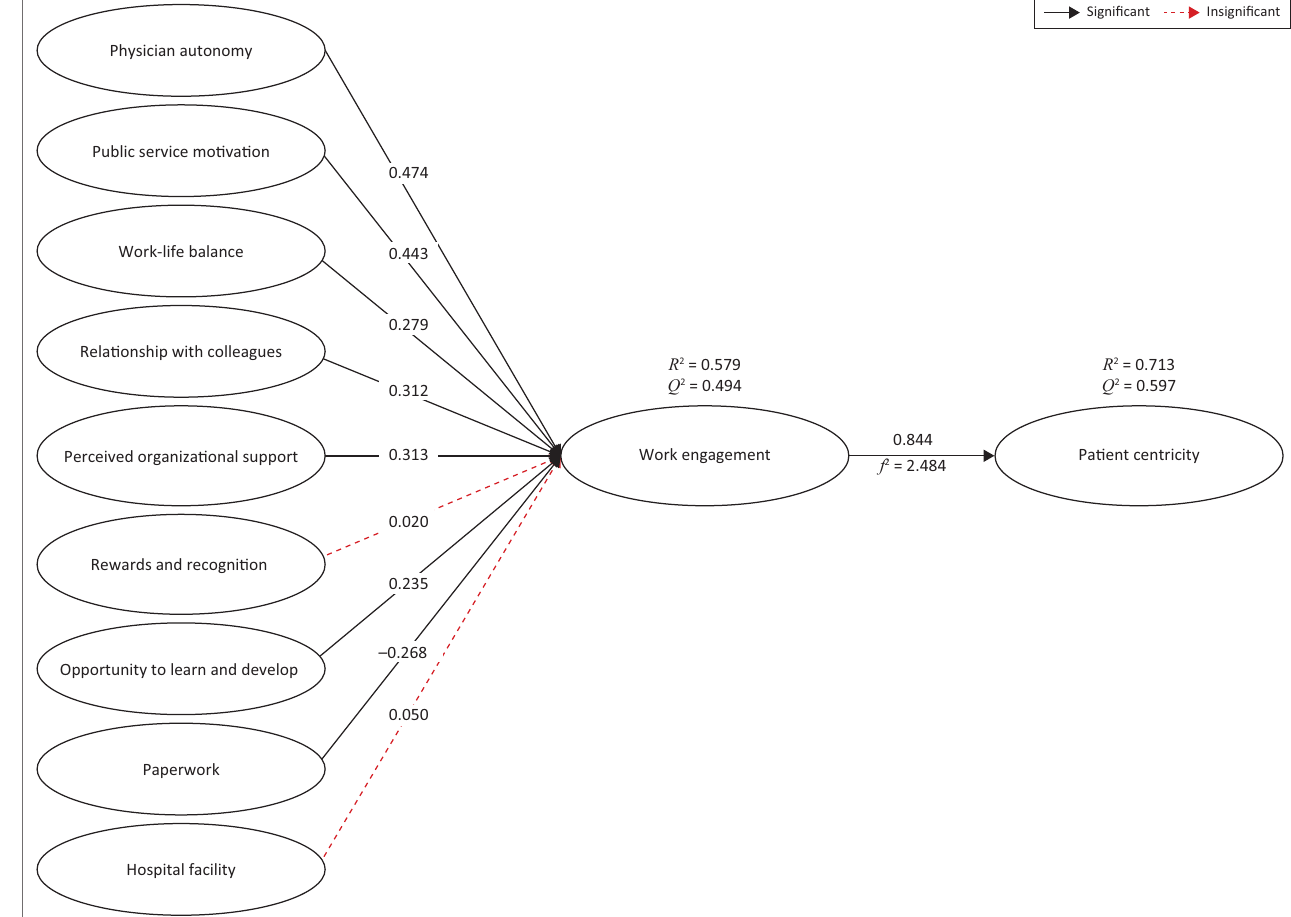
FIGURE 3 : Empirical